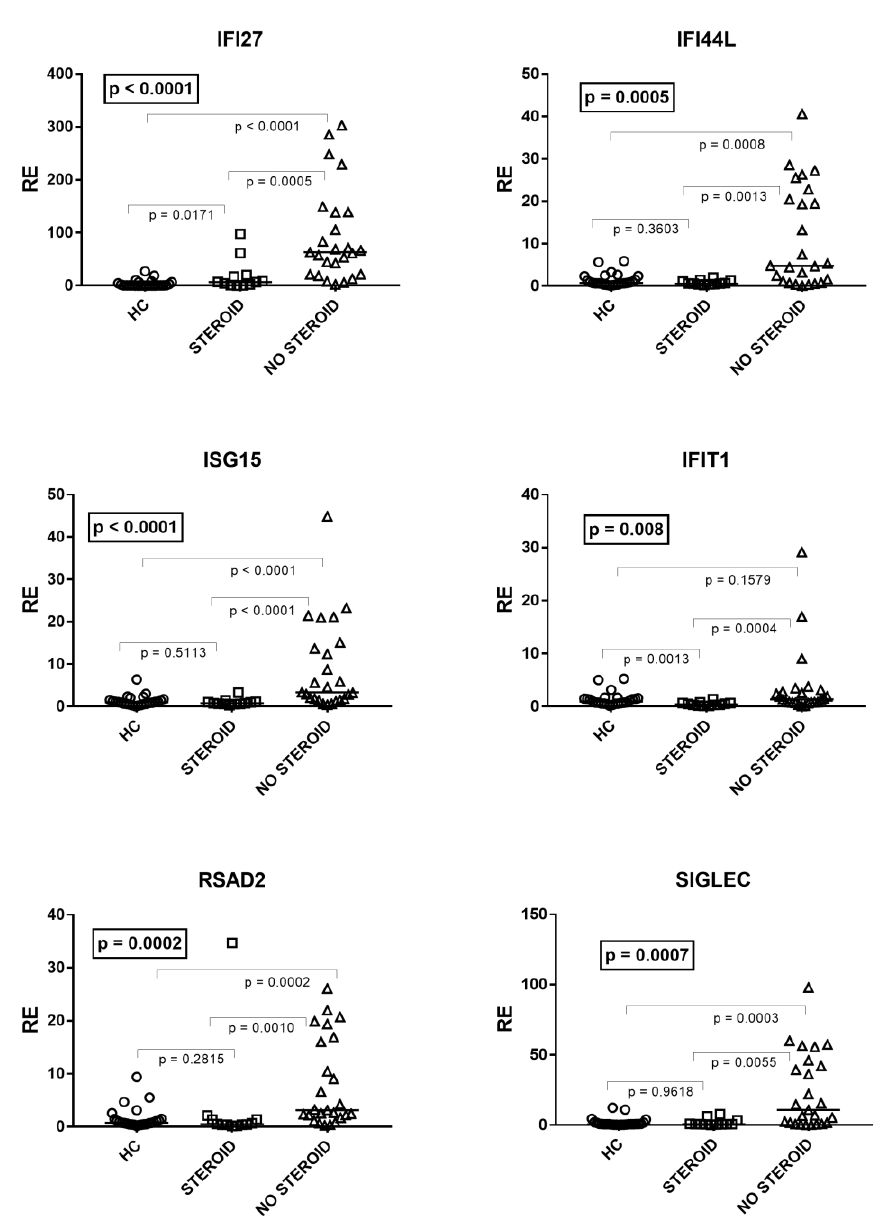
Figure 3. Expression of type I interferon stimulated genes (ISGs) in whole blood from 25 age-matched healthy children (HC), 12 children with acute RSV bronchiolitis on steroid treatment (Group A1), and 25 untreated patients (Group A2). RE: relative expression. Horizontal lines show the median values; squares, triangles, and circles show the mean of three individual measurements.